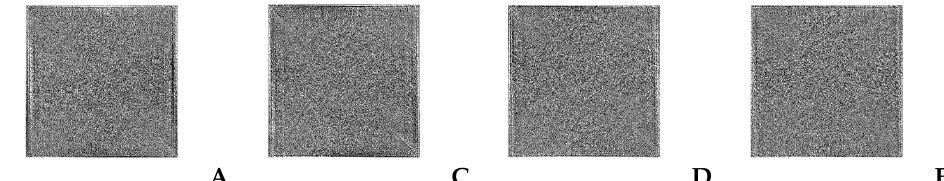
Figure 10. The QDFT results of the real component A , the imaginary component C , the imaginary component D , and the imaginary component E